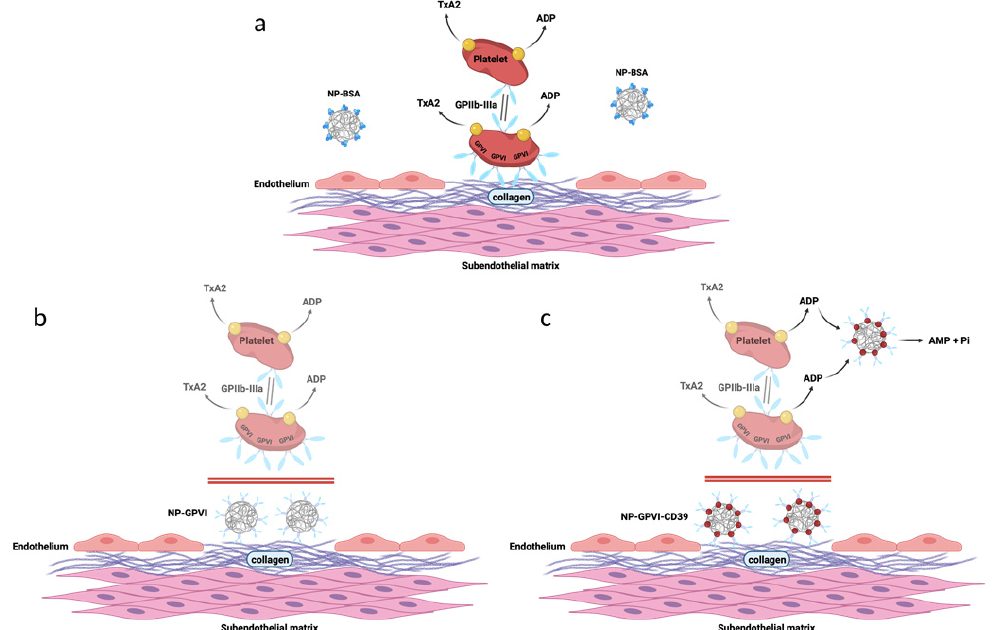
Figure 2. Schematic presentation of the hypothesized nanoparticle-induced modification of the hemostatic response following endothelial damage. Nanoparticle-specific mode of action at sites of endothelial damage. Due to the dimeric collagen receptor GPVI-Fc, both NP-GPVI ( b ) and NP- GPVI-CD39 ( c ) adhere to subendothelial collagen, thus competitively inhibiting platelet adhesion and collagen-induced platelet activation. Additionally, NP-GPVI-CD39 ( c ) degrades platelet-released ADP through ectonucleotidase CD39, thereby bifunctionally impairing platelet activation. ( a ) NP-BSA does not affect platelet adhesion. Created with BioRender.com; accessed on 18 July 2021).